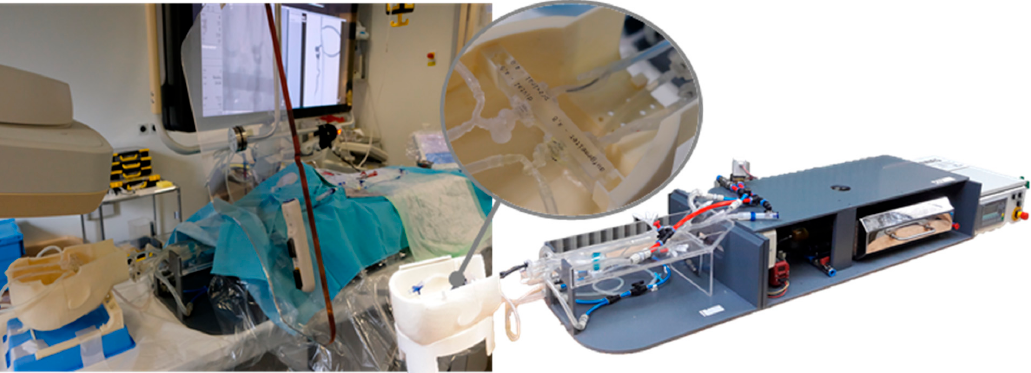
Figure 4. Hamburger Anatomical Neurointerventional Simulator HANNES with realistic replication of the relevant vessel tree for the evaluation of personalized flow diverter designs.